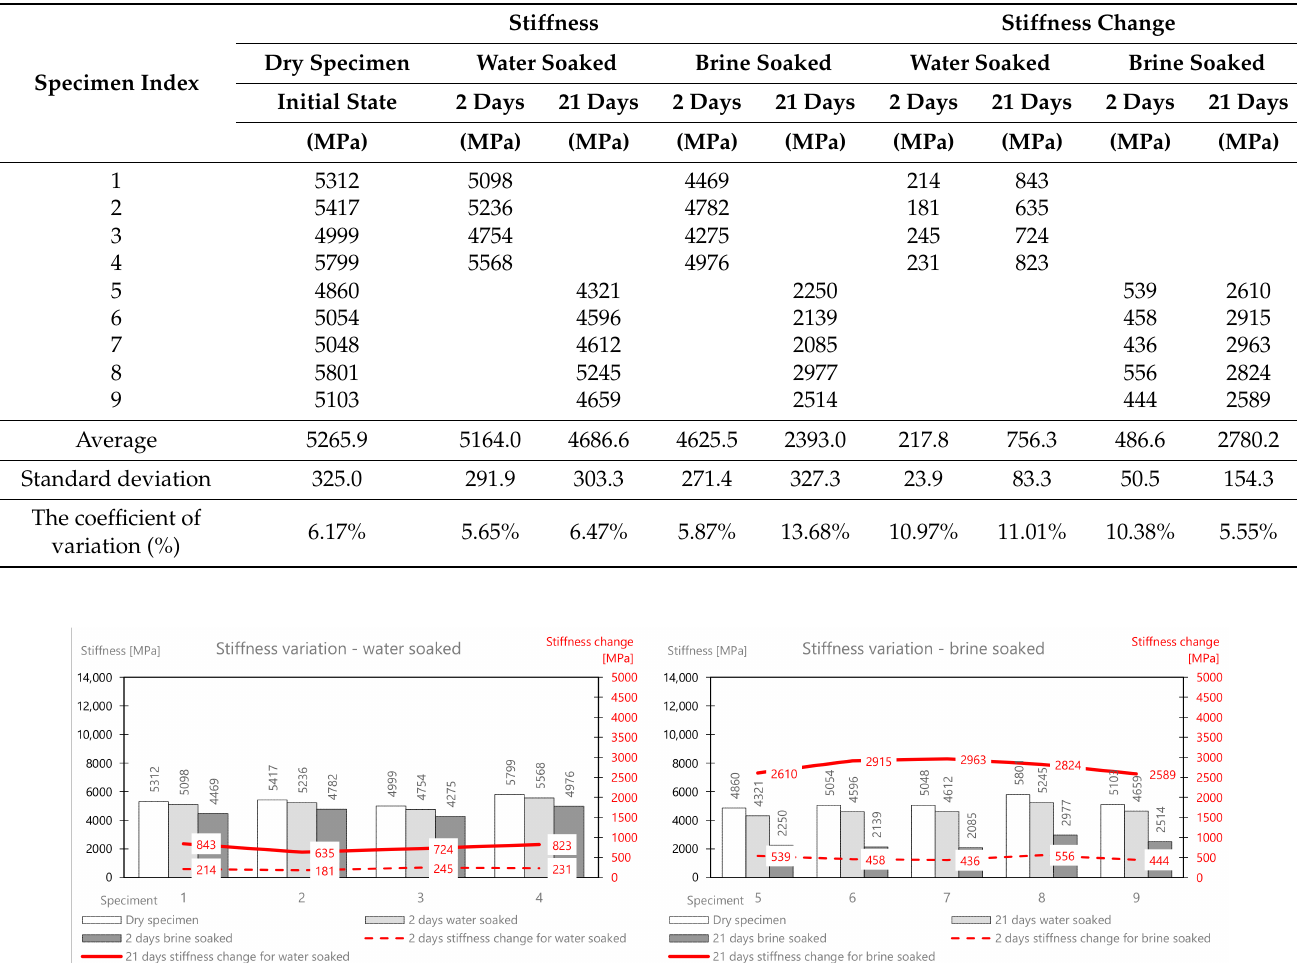
Figure 12. MCAS mix stiffness variation via water and brine